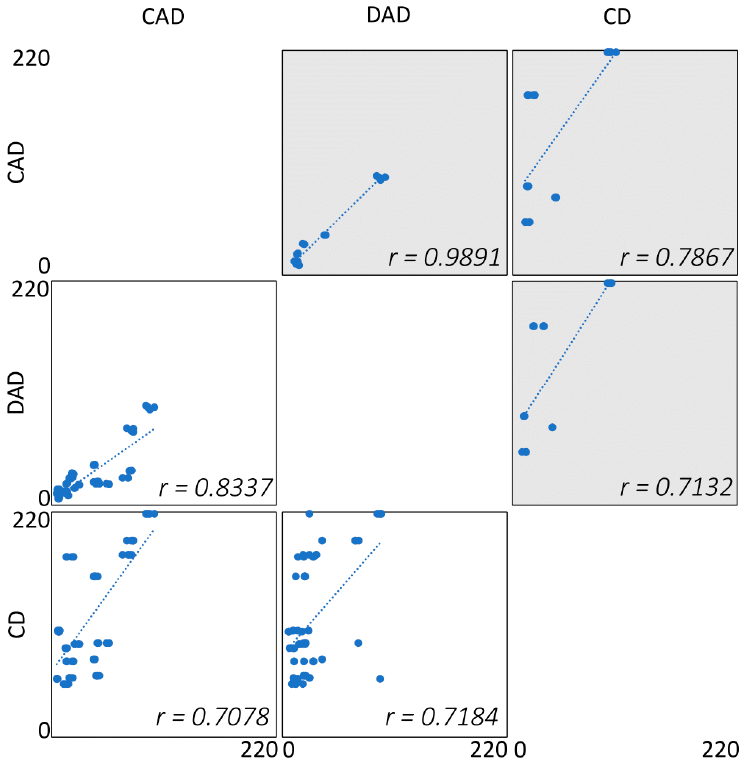
Figure 3. Pearson r correlation between detectors using all cultivars (62 data points, white back- ground) and selected cultivars that passed the t -test for similarity between total quantified polyphe- nols and antioxidant activity (18 data points, light grey background).